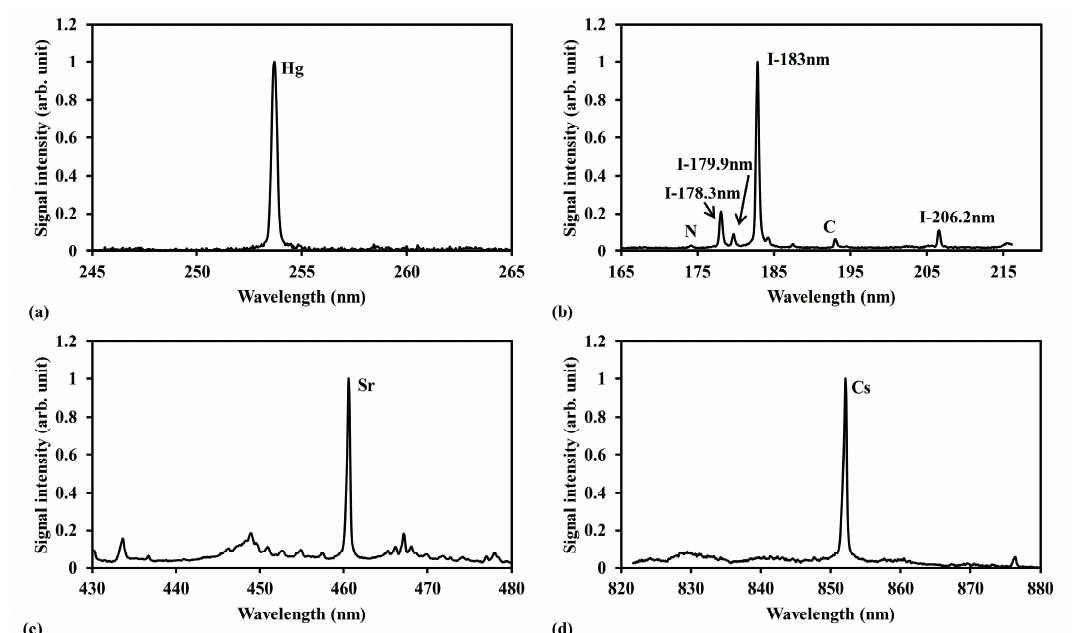
Figure 6. LIBS spectra of Hg, CH 3 I, Sr[C 5 (CH 3 ) 5 ] 2 and Cs(C 11 H 19 O 2 ) in N 2 . ( a ) Mercury measurement result. Conditions: ns 1064 nm laser irradiation, pressure 6600 Pa, delay time 1060 ns, power 400 mJ/p, beam diameter 9 mm, gate width 30 μ s. ( b ) Iodine measurement